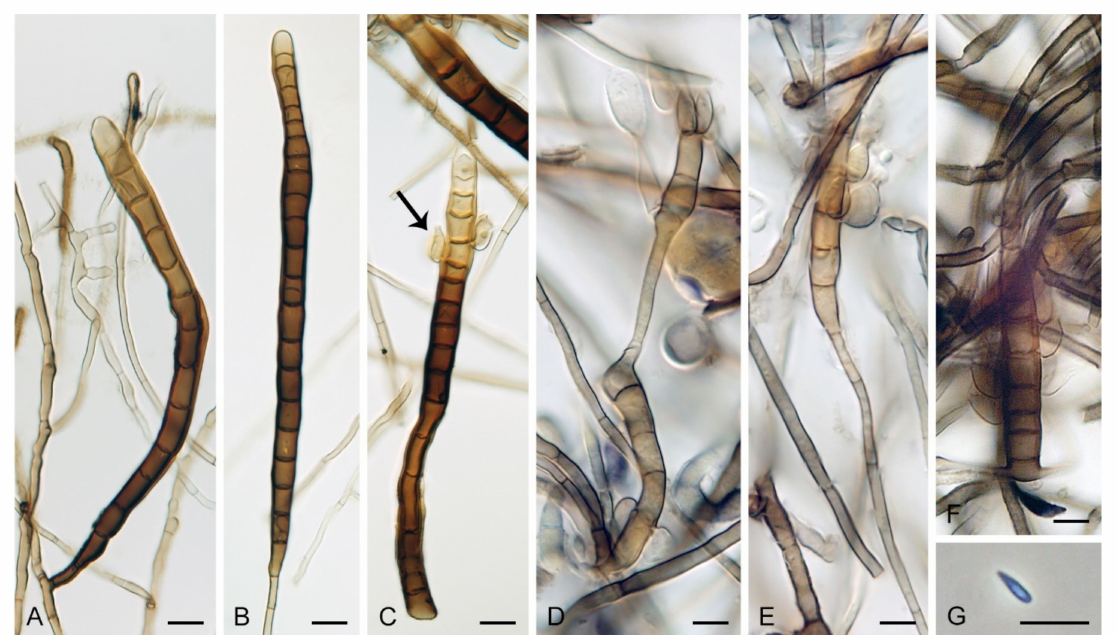
Figure 13. Zanclospora falcata (ICMP 23702 ex-type). ( A – C ) Stanjehughesia-like conidiophores (arrow indicates phialides). ( D – F ) Reduced Zanclospora conidiophores. ( G ) Microconidia. Images: ( A – G ) on MLA after 4–8 weeks. Bars: ( A – F ) = 10 µ m; ( G ) = 5 µ